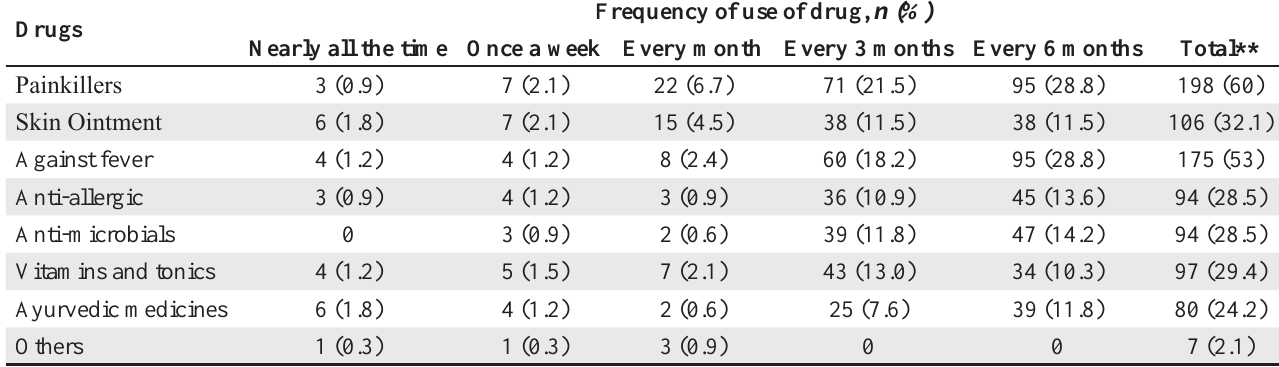
Table 4 : Practice of self-medication (Frequency of use of drugs for common health problems, N = 330)